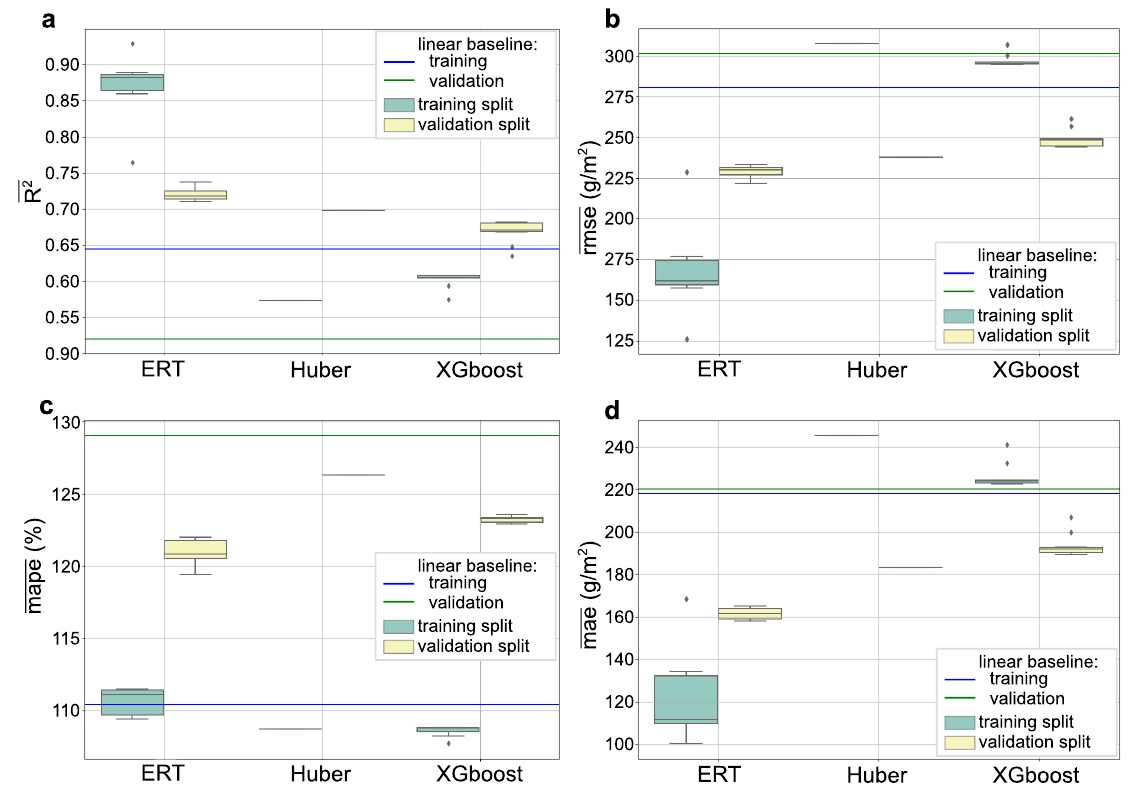
Figure 9. A comparison of the regression performances of the considered models using the training and validation datasets: ( a ) R 2 ; ( b ) RMSE ; ( c ) MAPE ; ( d ) MAE . The blue and green horizontal lines represent the performance of the linear regression baseline model using the training and validation sets, respectively. The overlined scores represent the mean values of 10 randomized